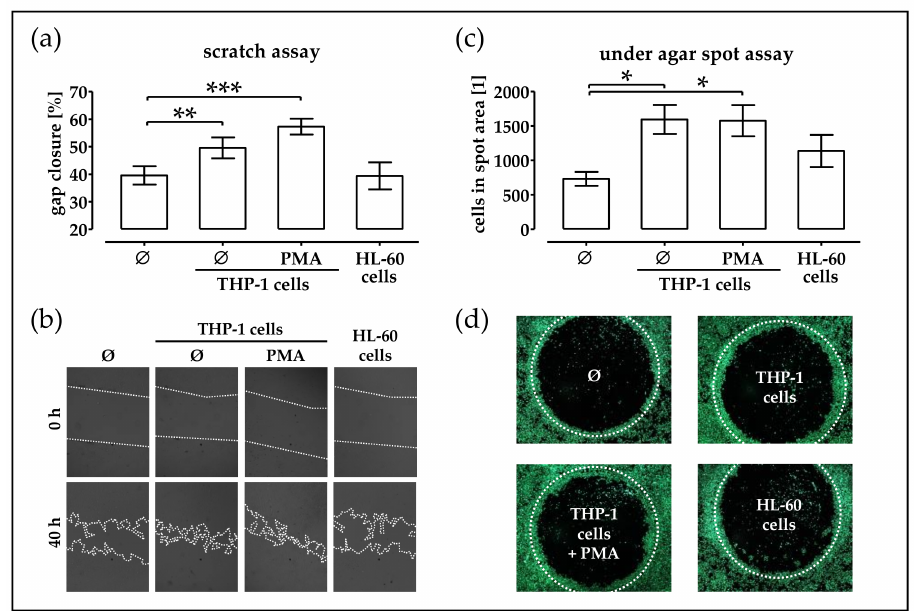
Figure 2. Conditioned medium from monocytic cells stimulates migration of phOBs. In order to investigate the influence of immune cell-conditioned medium on phOBs migration, a scratch assay and an under agar spot assay were performed. phOBs ( N ≥ 4, n ≥ 4) are stimulated with conditioned medium from THP-1 cells (representing monocytes), PMA-stimulated adherent THP-1 cells (representing macrophages), and DMSO-stimulated HL-60 cells (representing granulocytes). ( a ) For the scratch assay, gap closure was determined from microscopic images (100 − gap area 40h /gap area 0h × 100) with the help of the ImageJ software. ( b ) Representative microscopic images for the scratch assay (20 × magnification). ( c ) For the under agar spot assay, the number of cells in the spot area was determined from microscopic images with the help of the ImageJ software. ( d ) Representative microscopic images for the under agar spot assay (12.5 × magnification). Cells were visualized with Calcein-AM stain for living cells. Data are represented in bar diagrams (mean ± 95% C.I.). * p < 0.05, ** p < 0.01, and *** p < 0.001 as